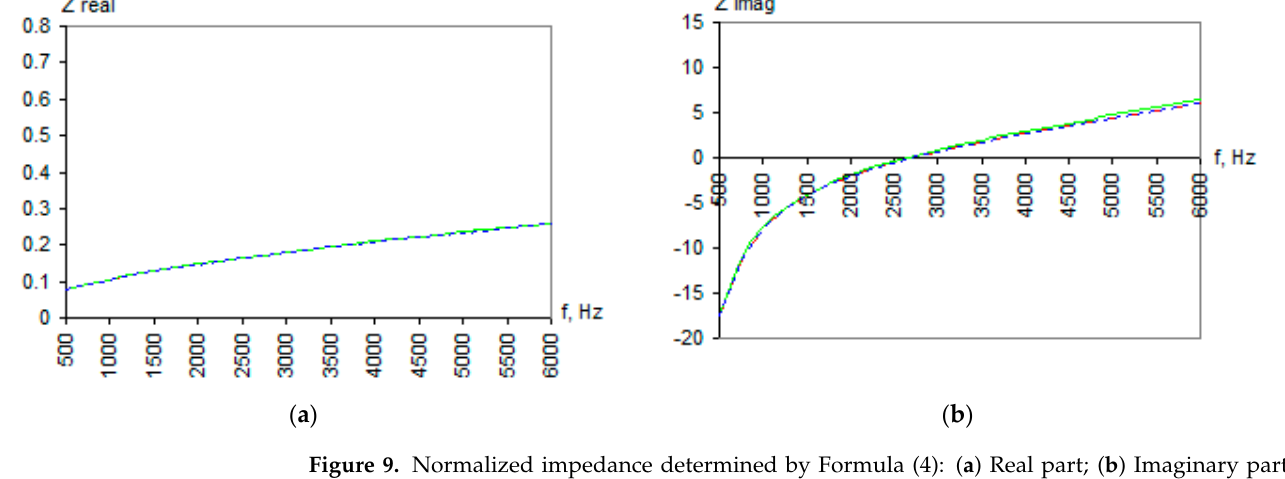
Figure 9. Normalized impedance determined by Formula (4): ( a ) Real part; ( b ) Imaginary part; Variant 1 of the orifice arrangement; Variant 2 of the orifice arrangement; Variant 3 of the orifice arrangement.